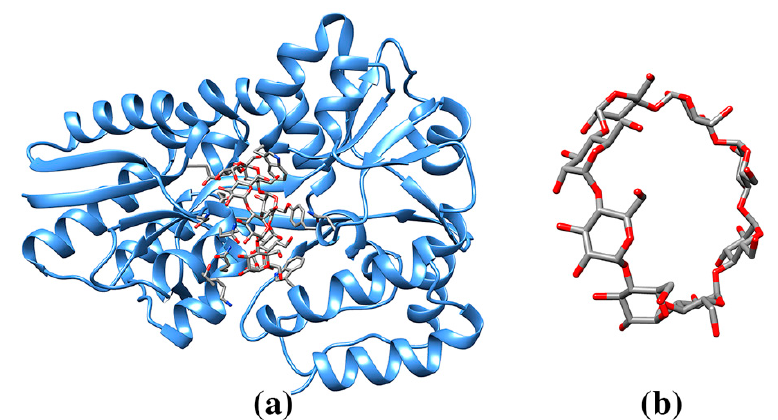
Figure 7. ( a ) Ribbon drawing of maltodextrin binding protein MalE1 in complex with γ -cyclodextrin (pdb entry 5mka). Cyclodextrin molecule hosts in its large cavity side chains of an asparagine and an alanine residue and in turn interact with the side chains of several aromatic residues. ( b ) γ -cyclodextrin molecule (cif code RCD).